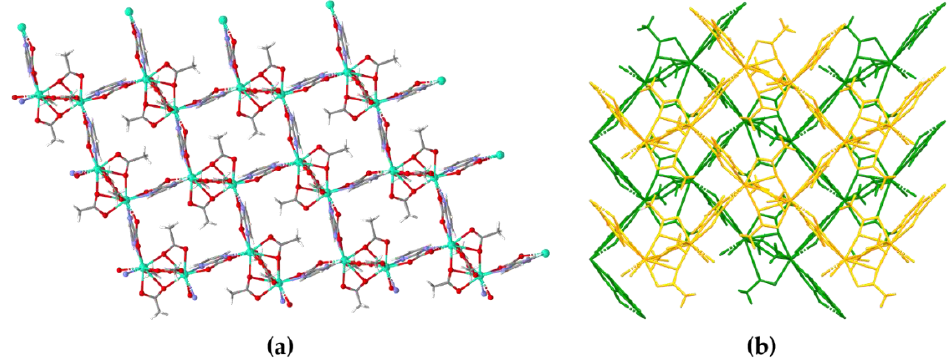
Figure 3. View of layers along the a-axis extended in the bc plane of compound 1 . ( a ) One layer in which it is possible to see the voids occupied by two acetate ligands; ( b ) Layers superimpose in a zig-zag arrangement, so there are no pores in the three-dimensional structure.